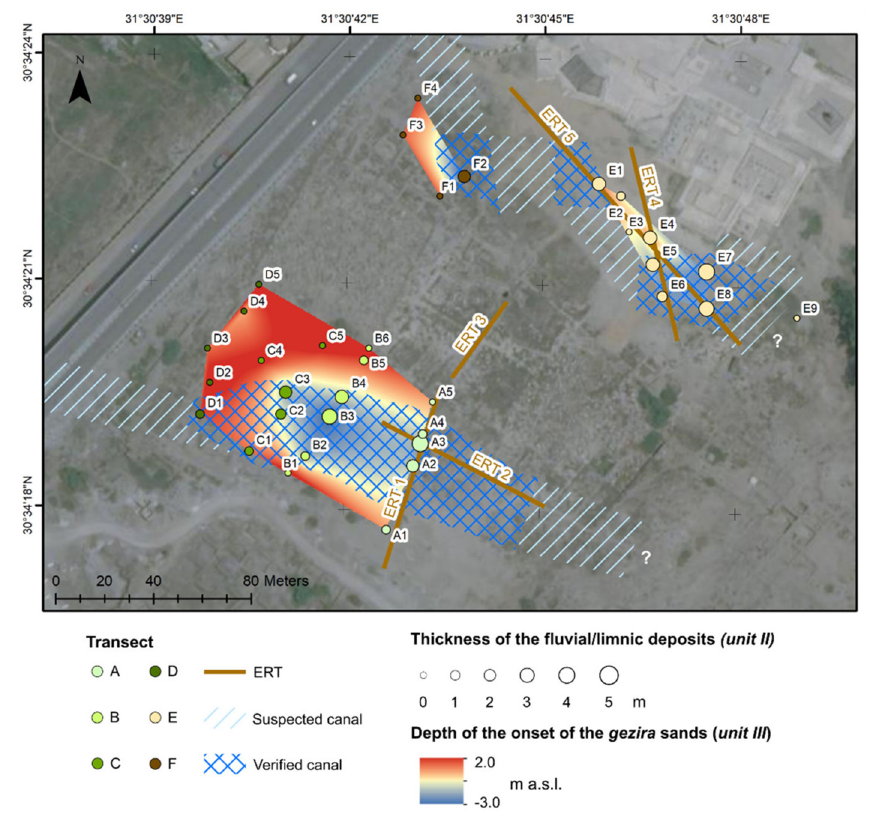
Figure 7. Depth of the onset of gezira sands ( unit III ), thicknesses of fluvial/limnic layers ( unit II ) and position of the verified/suspected canals (Database: © Esri